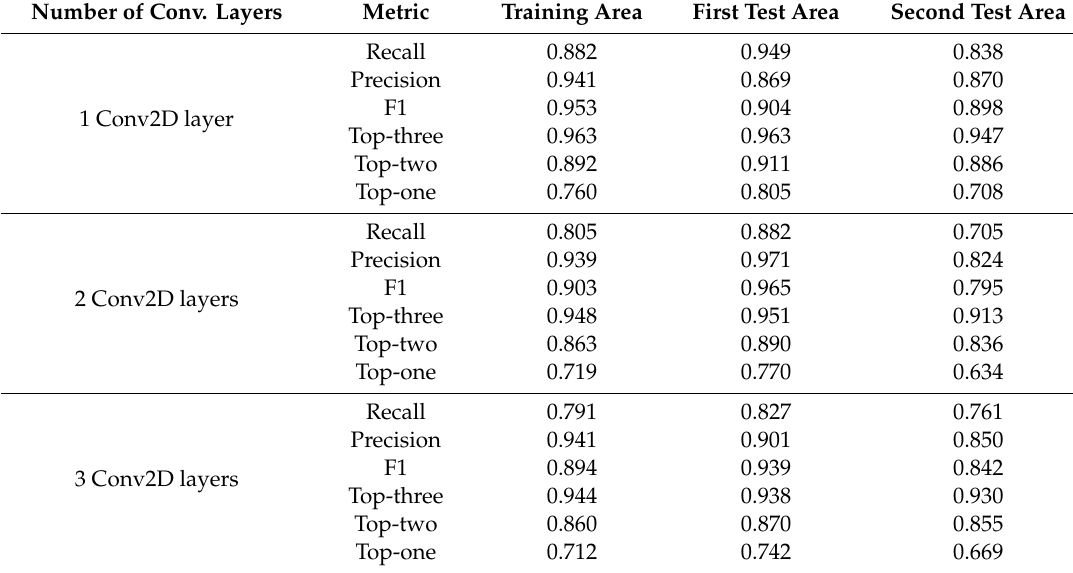
Table 4. Impact of the network’s depth on feature extraction for the first and second datasets. Number of Conv. Layers